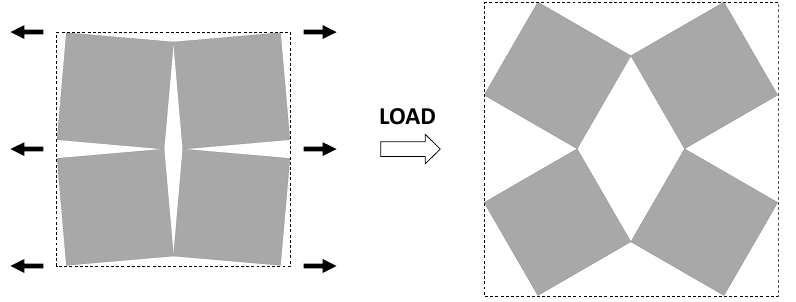
Figure 1. A network of rigid squares connected at their corners through flexible hinges expands when uniaxially stretched, preserving the aspect ratio in the process.